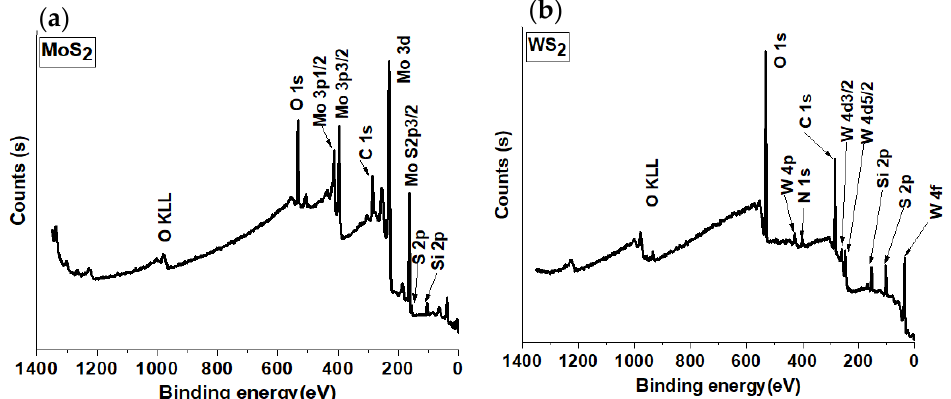
Figure 6. ( a , b ) General XPS survey spectrum distributions of both MoS 2 and WS 2 thin films.